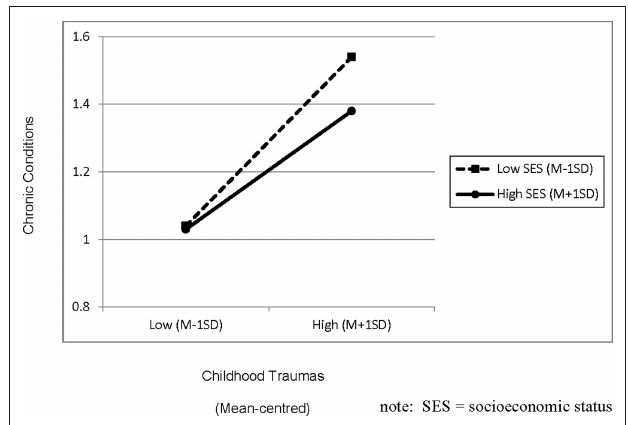
Figure 2 | Association between childhood trauma and chronic illness in adulthood moderated by socioeconomic